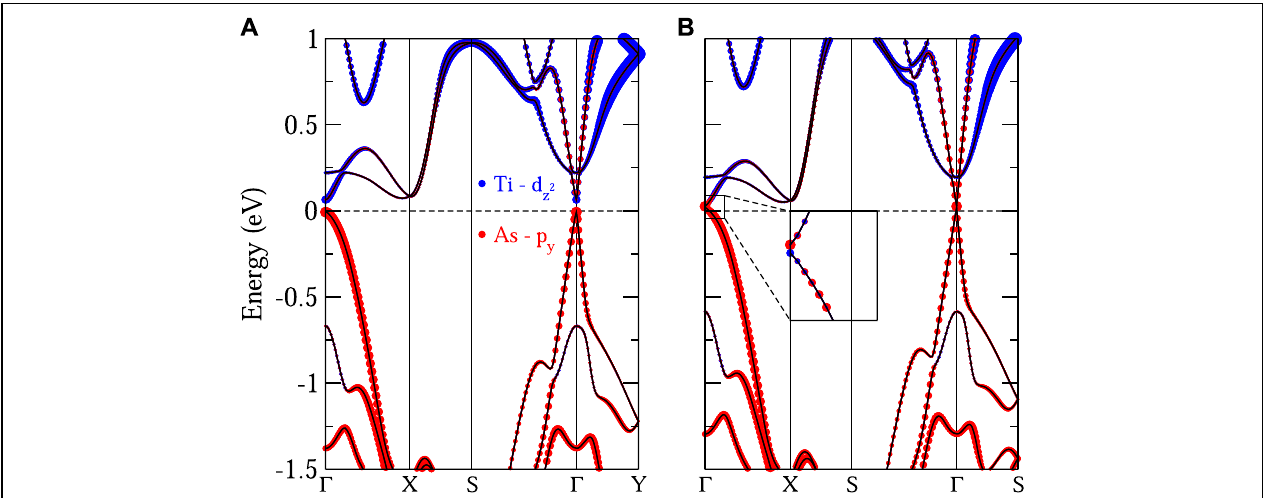
FIGURE 4 | The band structure of single-layer TiAsI: (A) strain-free and (B) 2% strain. The color representation of the orbital decomposition is remarked in (A) for both cases. The inset in (B) shows the band inversion of the nontrivial phase.